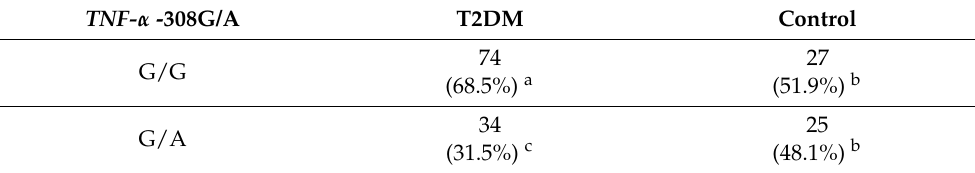
Table 3. Frequency of TNF- α -308G/A genotypes in T2DM and control subjects. TNF- α -308G/A T2DM